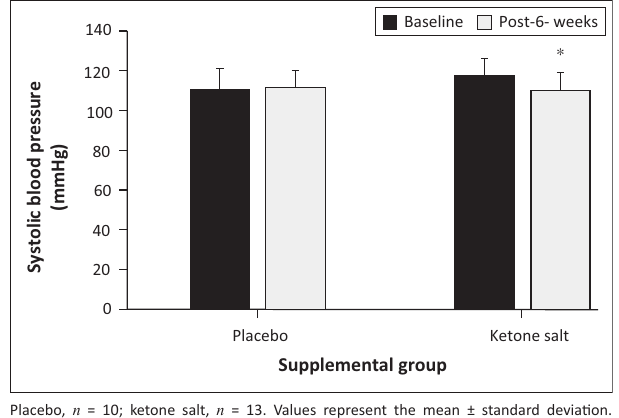
FIGURE 2: Systolic blood pressure before and after taking the placebo or ketone salt supplement daily for 6